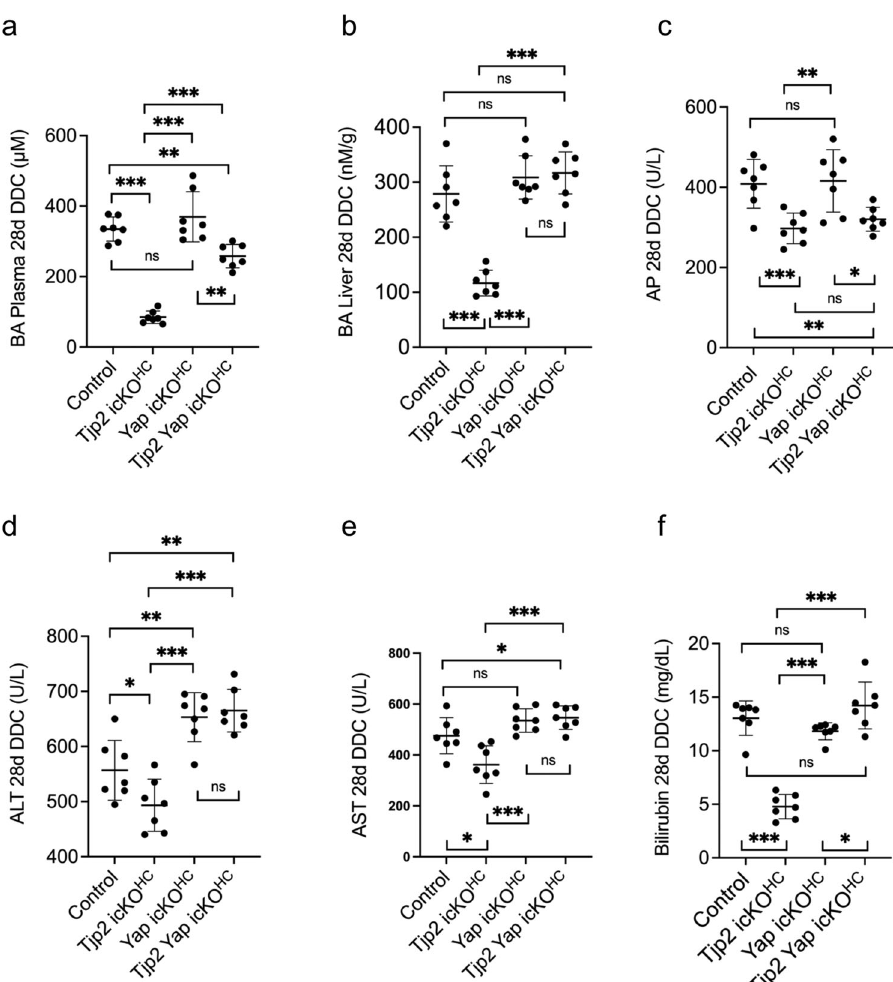
Fig. 6 Biochemical analysis of liver and plasma marker levels for control, Tjp2 icKO HC , Yap icKO HC , and Tjp2 Yap icKO HC mice fed a 28-day DDC diet. a Plasma BA, ( b ) liver BA, ( c ) AP, ( d ) ALT, ( e ) AST, ( f ) Bilirubin. Data are shown as mean ± SD, unpaired Student ’ s t test. * p < 0.05; ** p < 0.005, *** p < 0.0005, ns — not signi fi cant ( p > 0.05), with p < 0.05 considered a signi fi cant difference. n = 7 mice per cohort. icKO HH , tamoxifen-induced hepatocyte